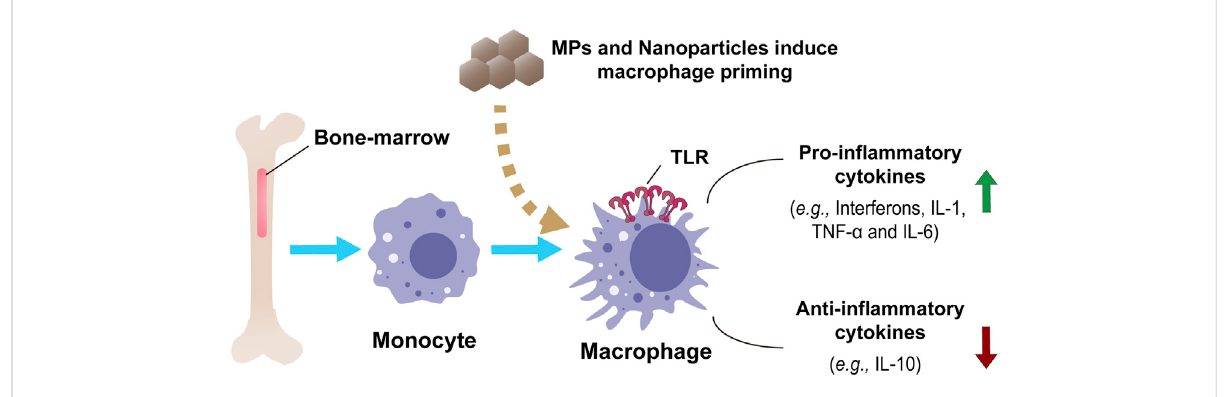
FIGURE 3 In vitro model of macrophage priming and innate immune functions in human monocytes and monocyte-derived macrophages by nanoparticles or MPs. Bone-marrow-derived macrophages show an innate response in producing and regulating in fl ammatory and anti- in fl ammatory cytokines.